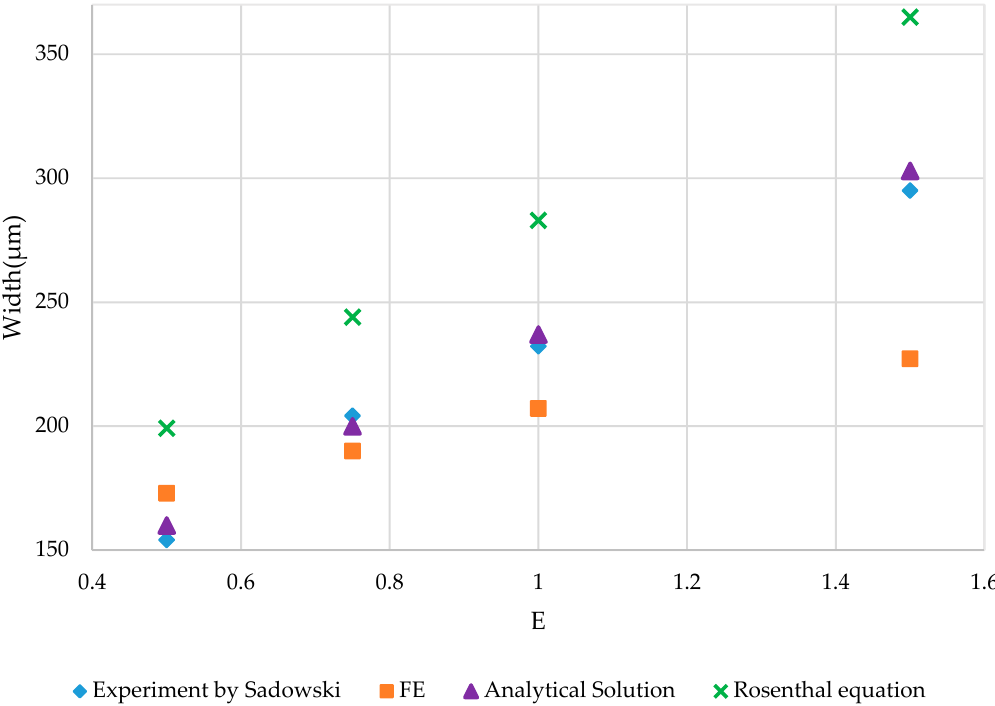
Figure 5. The dimension of melt pool of In718 by SLM processing at high heat input from experiment by Sadowski [12], FE modeling and analytical solution (equation from this paper and Rosenthal equation).